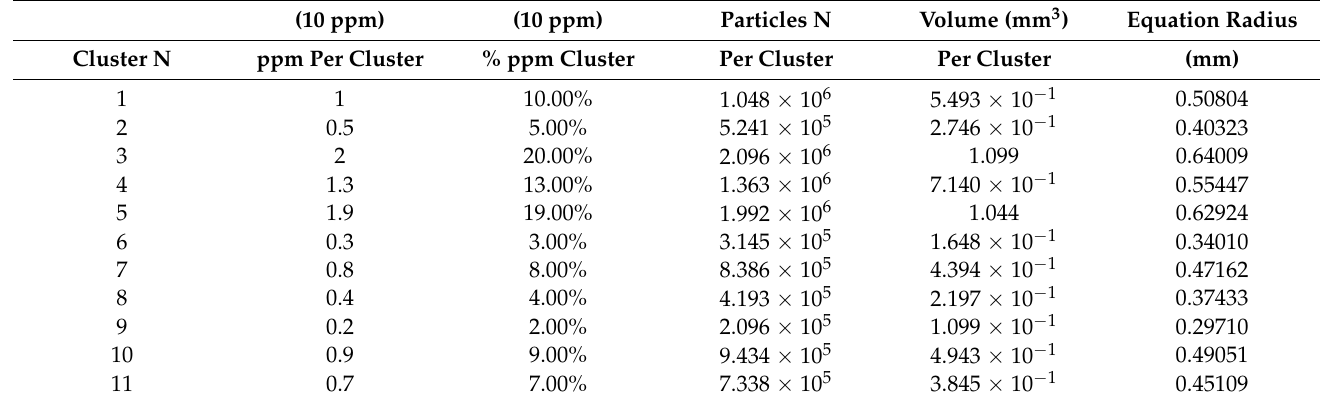
Table 6. Cluster configuration—10 ppm PO$ Group.